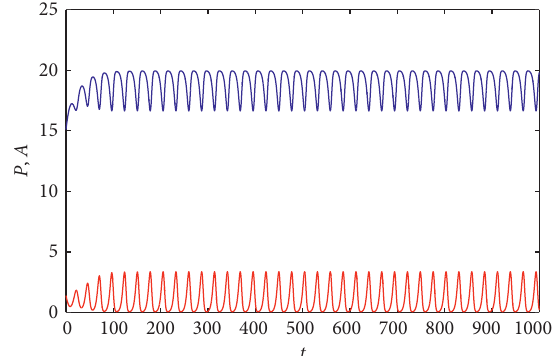
Figure 1: Graph of P ∗ and A ∗ versus τ for system (4).